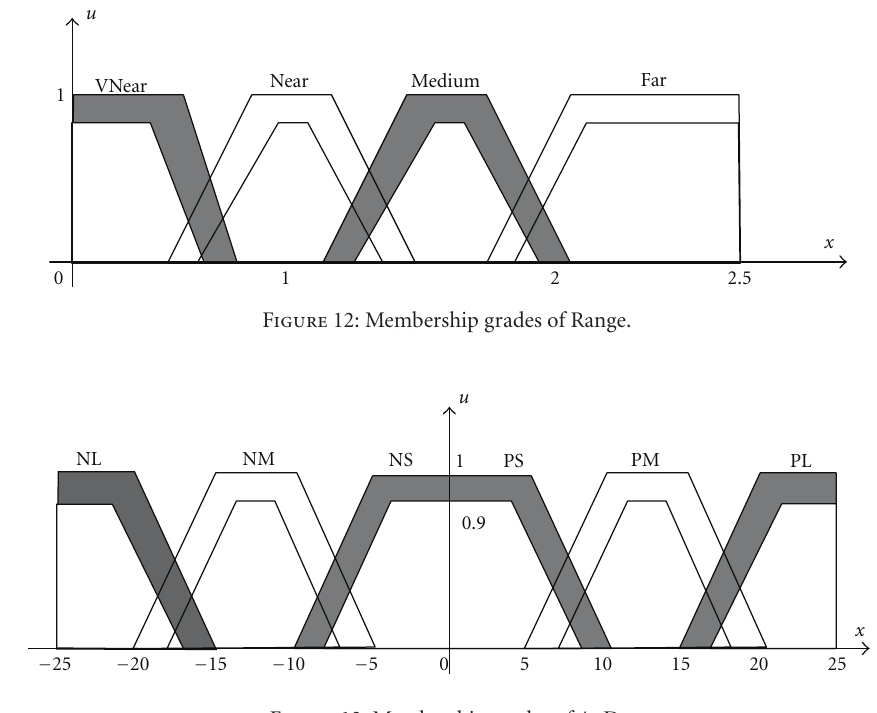
Figure 13: Membership grades of AoD.